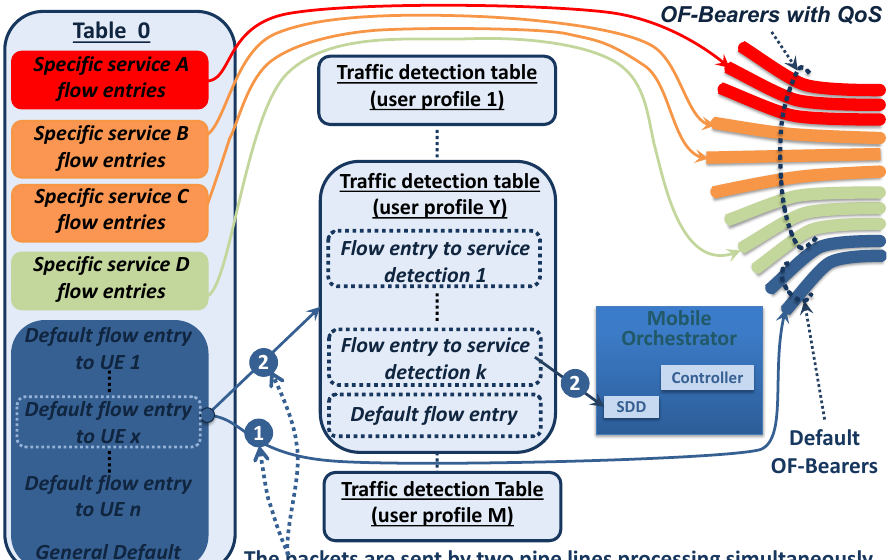
Traffic detection table